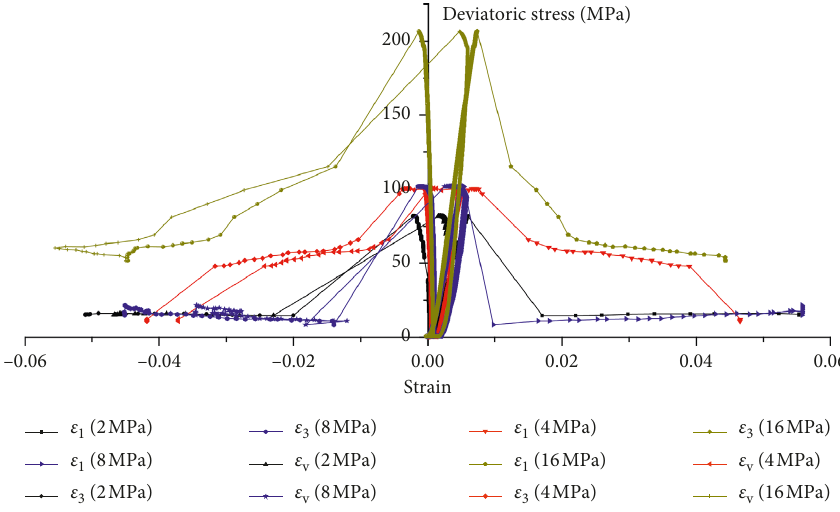
Figure 6: The curves of b2 rocks for triaxial unloading Table 2: The mechanical parameters of b2 rocks under unloading conditions. Specimen no.